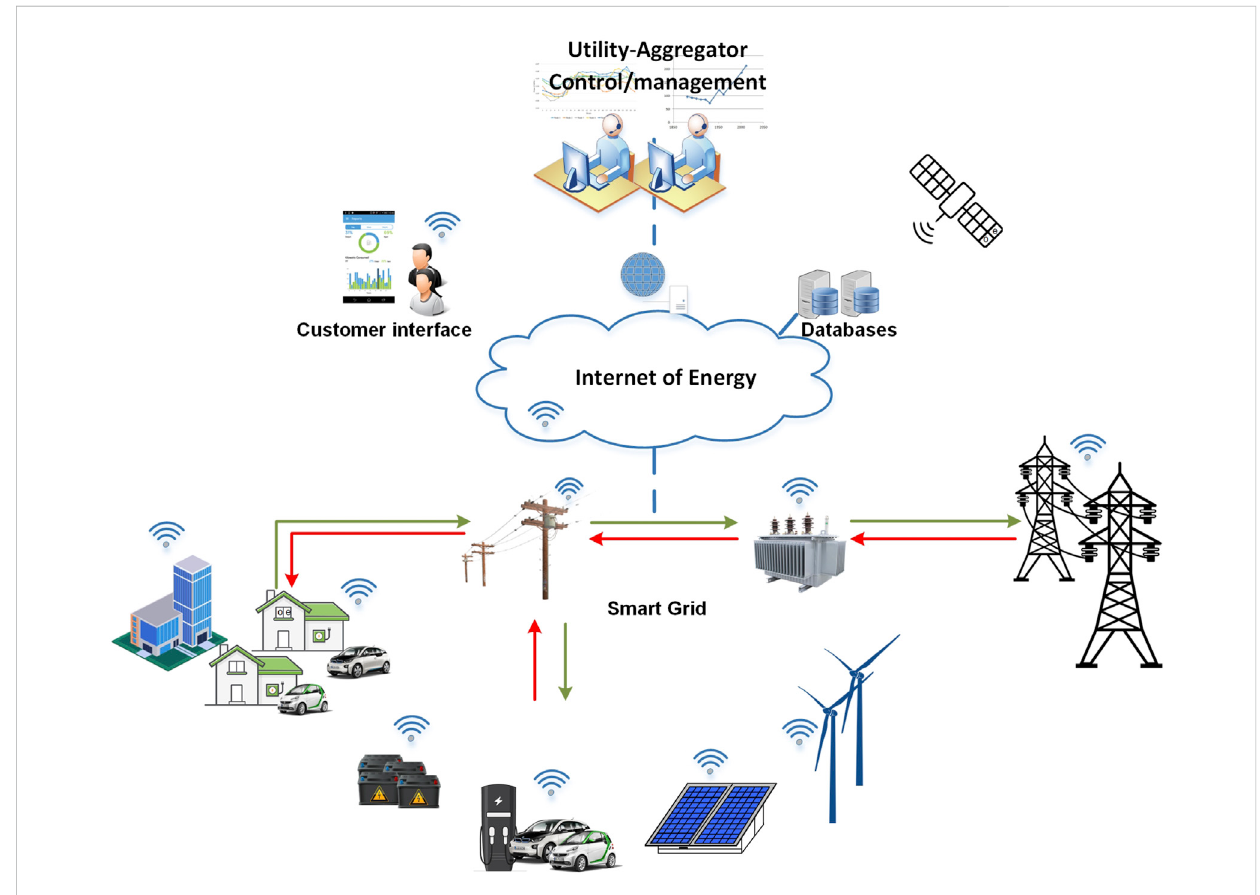
FIGURE 1 The structure of the Internet of Energy